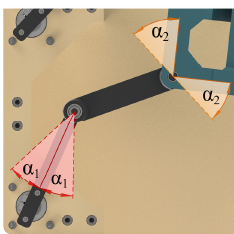
Figure 5. Design limitations in the manipulator kinematic chains: both angles α 1 and α 2 are in the manipulator model shown in Figure 1b; only angles α 1 are in the manipulator model shown in Figure 1c. in general, located near the edge of the workspace.